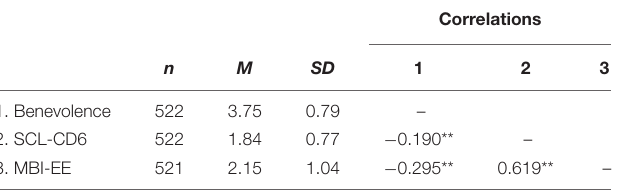
TABLE 1 | Study 1: Descriptive statistics and